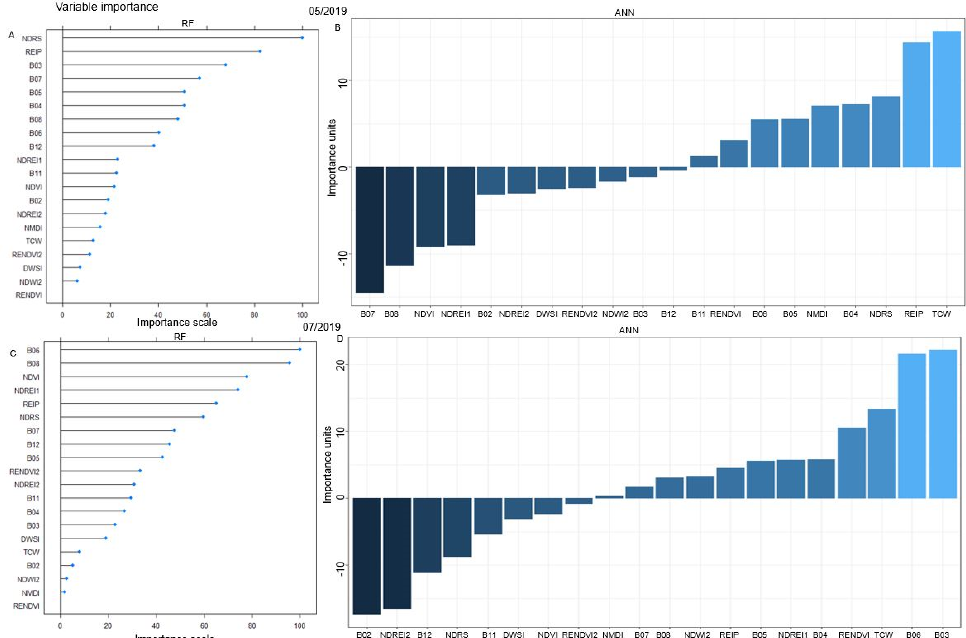
Figure A1. Variable importance for RF and ANN for classification datasets (May 2019 ( A , B ) and July 2019 ( C , D )). Importance values for each explanatory variable for RF are expressed on a scale from 0 to 100 and were calculated with the R “caret” package (version 6.0.91). Variable importance for ANN was calculated with the R “NeuralNetTools” package (version 1.5.3) based on relative importance of input variables in neural networks as the sum of the products of raw input–hidden and hidden– output connection weights, proposed by Olden et al. [55]. The importance values assigned to each variable are in units that are based directly on the summed product of the connection weights. The actual values should only be interpreted based on relative sign and magnitude between explanatory variables. Comparisons between different models should not be made [55].